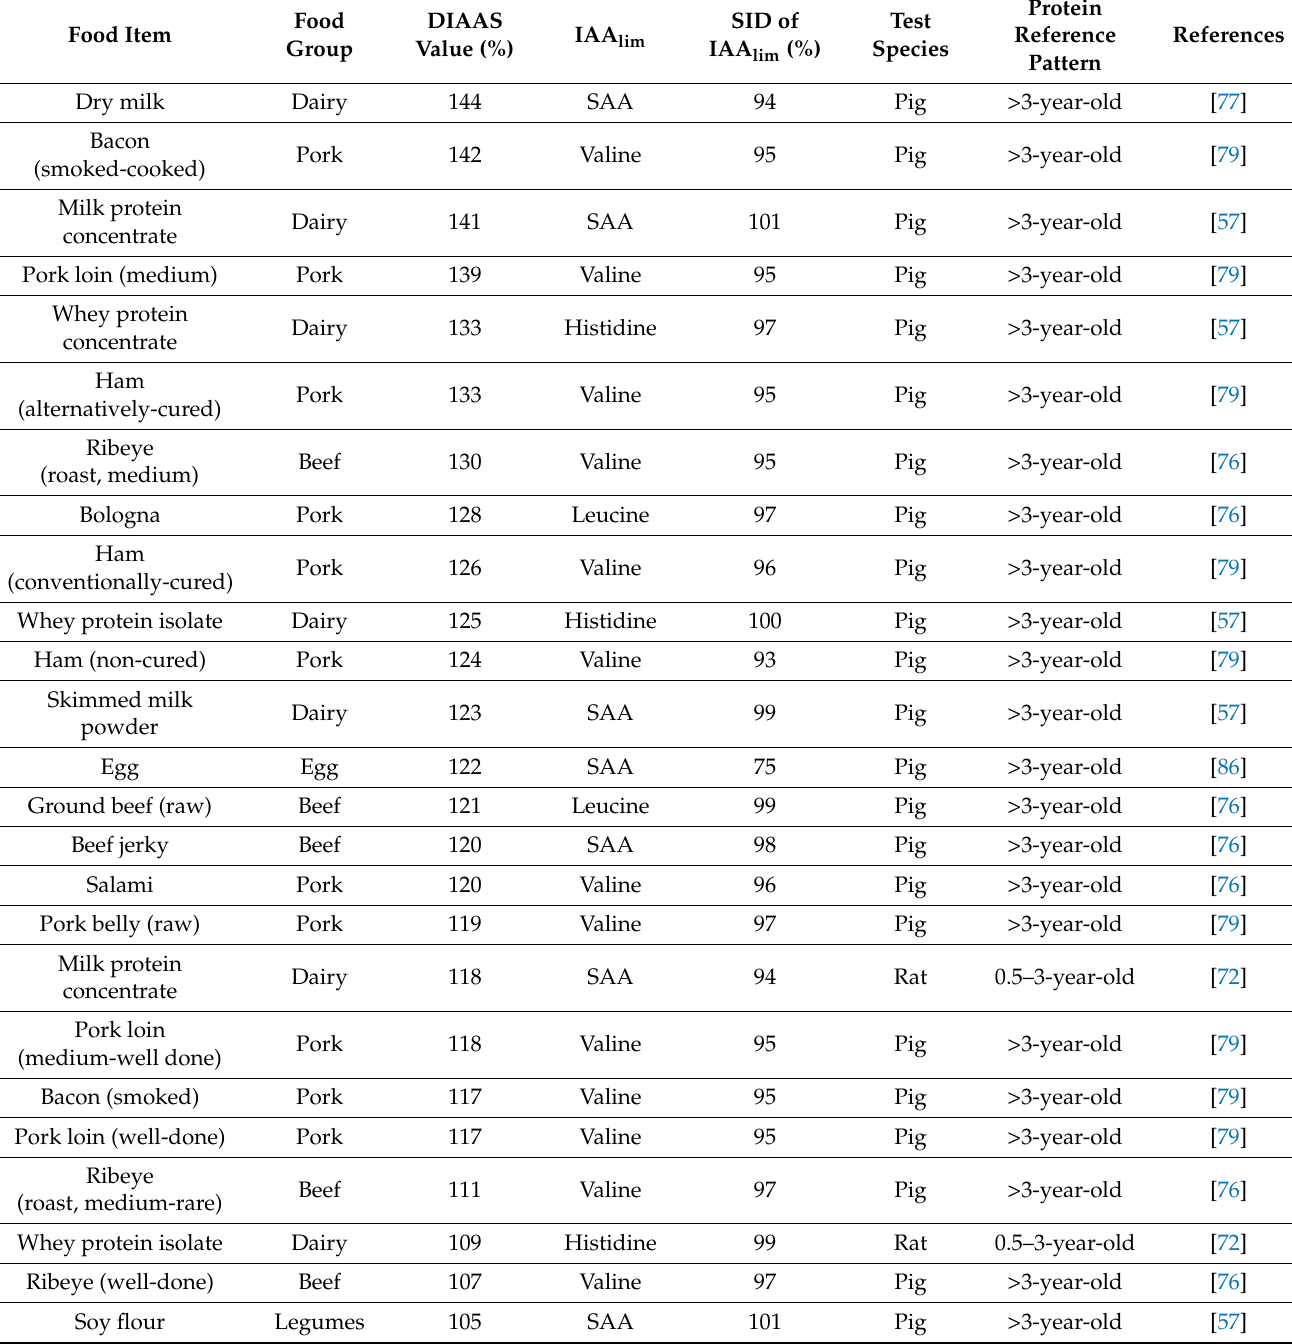
Table 4. Overview of digestible indispensable amino acid score (DIAAS) values, including the first limiting indispensable amino acid (IAA lim ) and its standardized ileal digestibility (SID) as well as the species in which testing was performed and the protein reference pattern against which DIAAS was calculated for different food items. Items are ranked from highest to lowest DIAAS value 1